Question: Draft a figure caption describing what is shown.
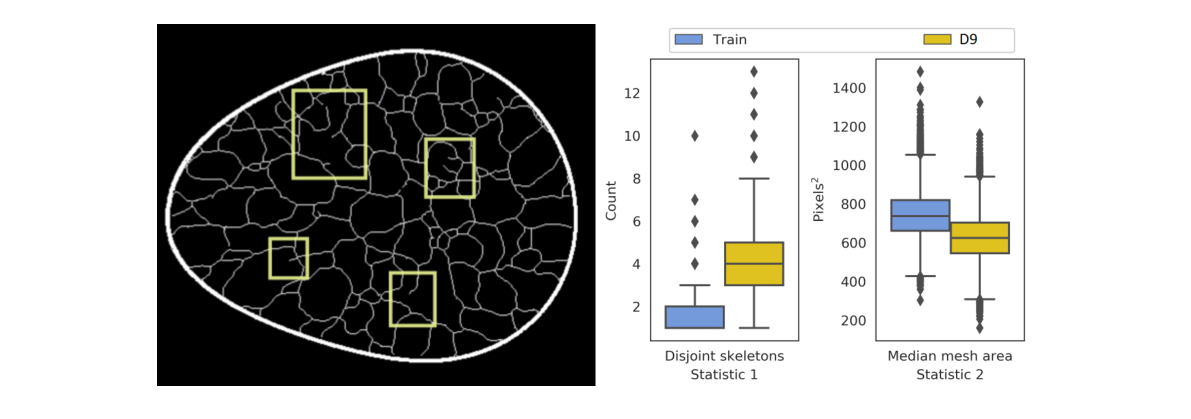
Answer: A thresholded sample image (left) from the top-ranked submission (D9) demon- strated clear breaks in ligament connections (yellow boxes). These artifacts were also re- flected in two statistics: number of disconnected skeletons per-image, and the median area of bounded regions within an image. The boxplots correspond to 10,000 images each, from the training dataset, and the top-ranked submission.